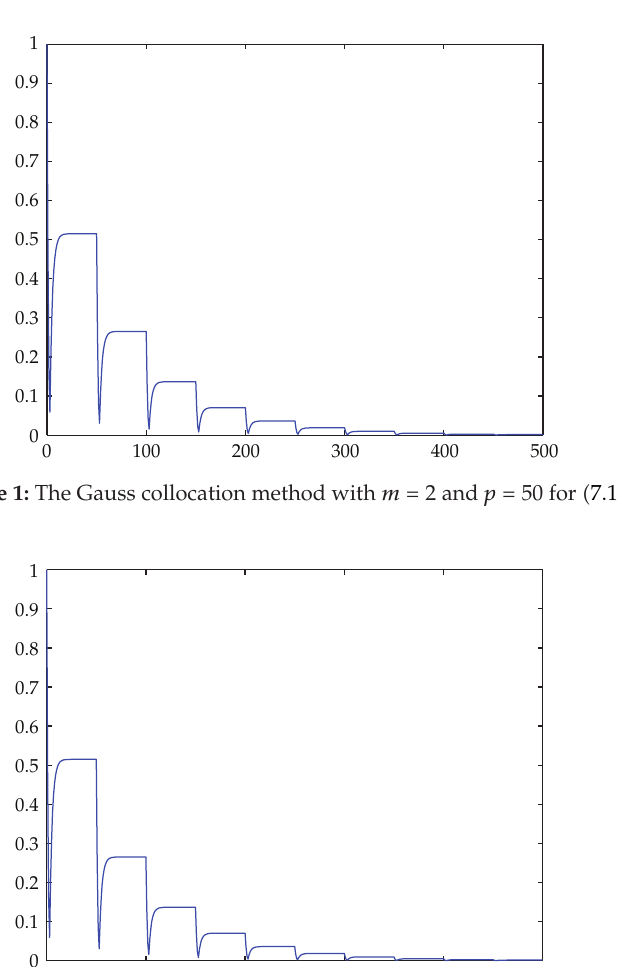
(cid:2) i (cid:3) (cid:2) I − xA (cid:3) is invertible. (cid:2) ii (cid:3) for any given u (cid:2) 1 ≤ i ≤ m (cid:3) relation (cid:2) 6.4 (cid:3) defines U i → 0 for k → ∞ U k